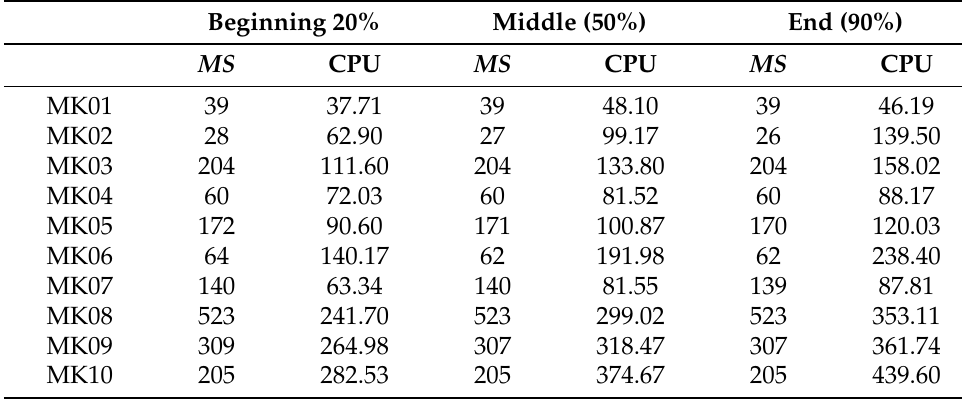
Table 11. E2L-PSO medium CPU reduction needed